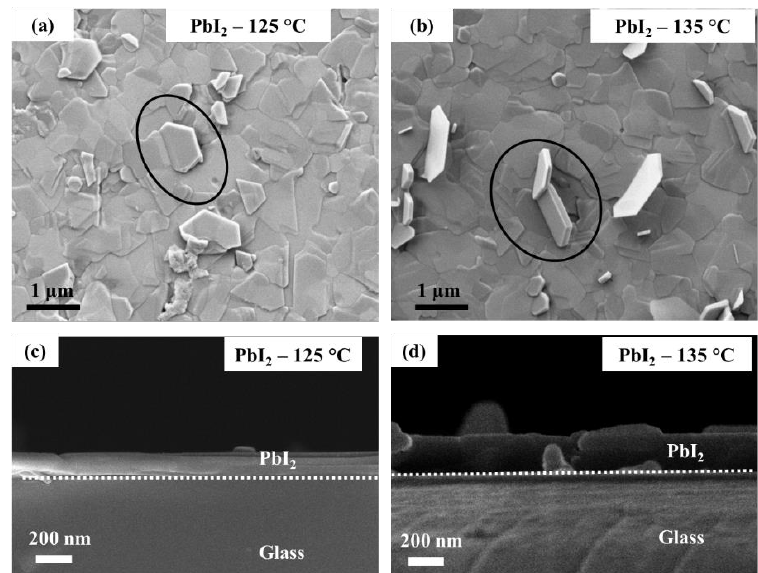
Figure 3. Planar SEM micrographs (high magnification) of PbI 2 thin films deposited from different substrate temperatures: ( a ) 125 °C and ( b ) 135 °C, as shown on the micrographs; ( c , d ) corresponding cross-sectional SEM of the PbI 2 thin films on glass substrates.